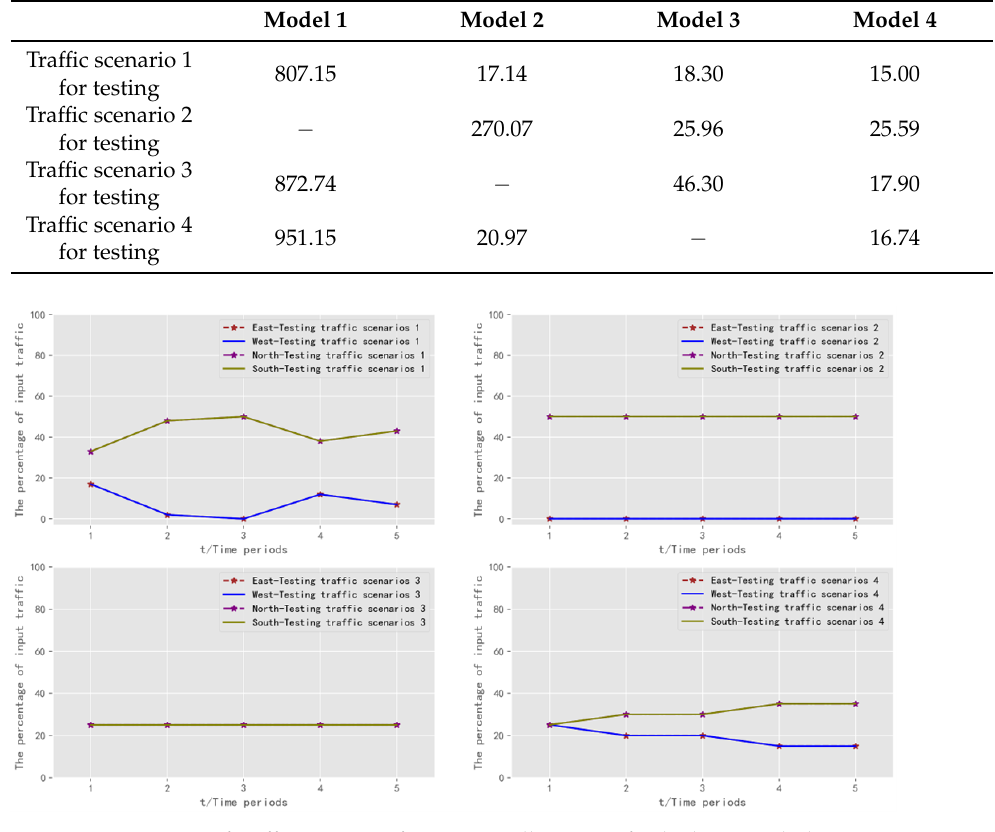
Figure 11. Diagram of traffic scenarios for testing: allocation of vehicles in each